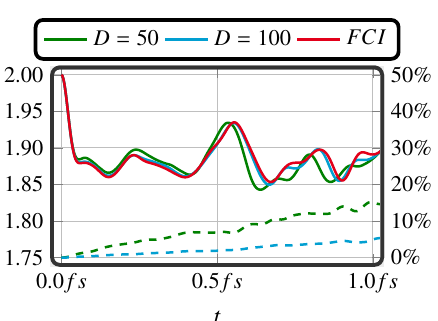
Figure 2: Occupation number of the HOMO-1 of a water molecule with doubly ionized 1 s orbital at the oxygen atom at time t =